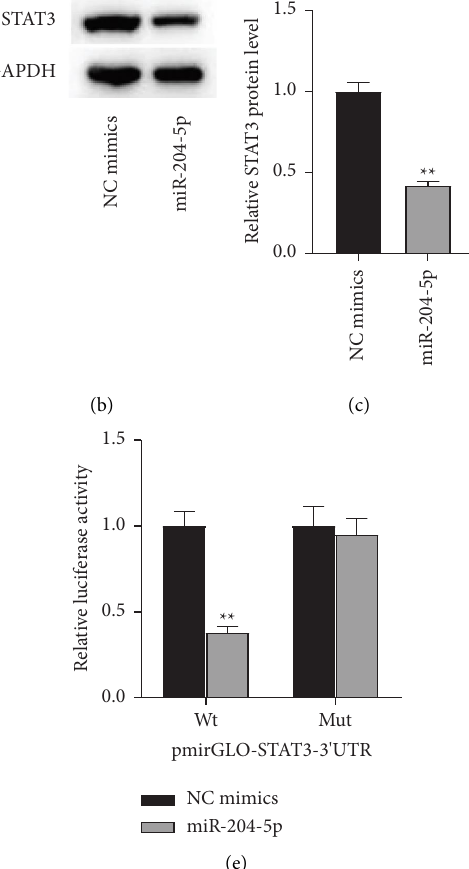
Figure 3: MiR-204-5p targets STAT3 in HaCaT cells. (a) Relative expression of miR-204-5p and STAT3 in HaCaT cells transfected with NC mimics or miR-204-5p mimics examined by RT-qPCR. (b and c) Te STAT3 protein level in HaCaTcells with the transfection of NC mimics or miR-204-5p mimics examined by Western blot analysis. (d) Binding sequences between miR-204-5p and STAT3. (e) Te combination between miR-204-5p and STAT3 validated by luciferase reporter assay. Each bar presents the mean ± standard deviation obtained from three to four separate experiments. ∗∗ P < 0 . 01, ∗∗∗ P < 0 . 001 compared to the model